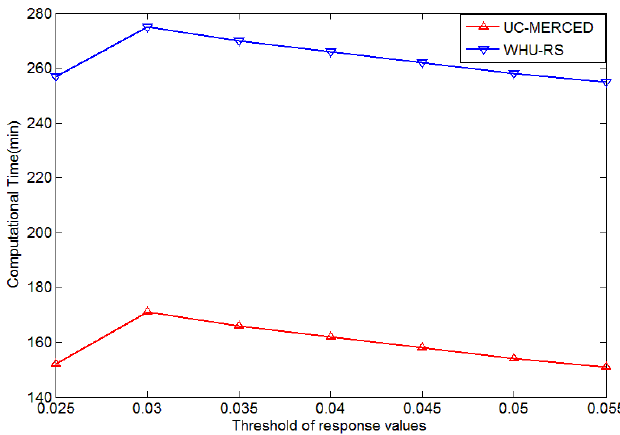
Figure 15. Computational time for vector quantization with different thresholds of response value.